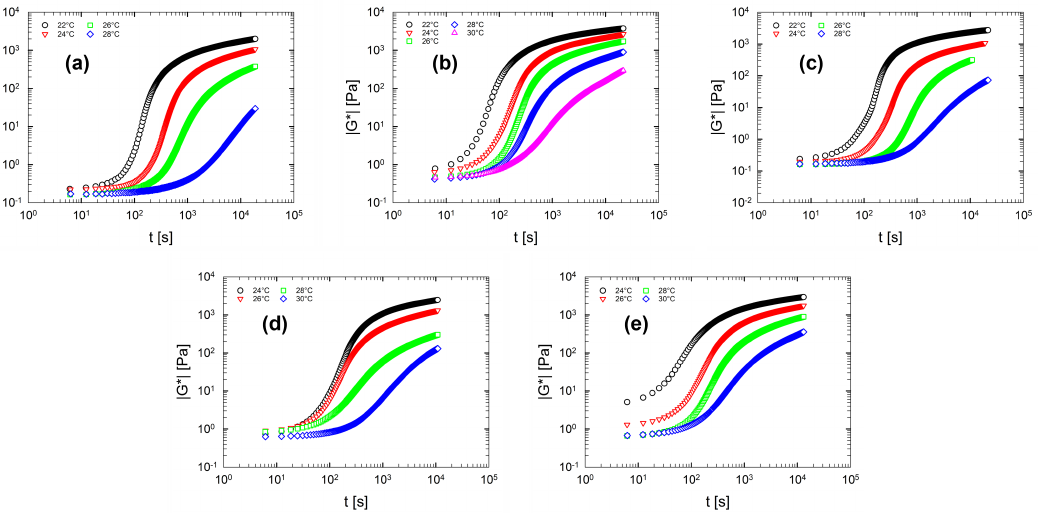
Figure 7. Gelation kinetics for multi-component aqueous gelatin solutions. For each solution the complex modulus as a function of the time in a selected temperature range is reported. ( a ) Sol. 2; ( b ) Sol. 3S; ( c ) Sol. 3D; ( d ) Sol. 4; ( e ) Sol. 5.